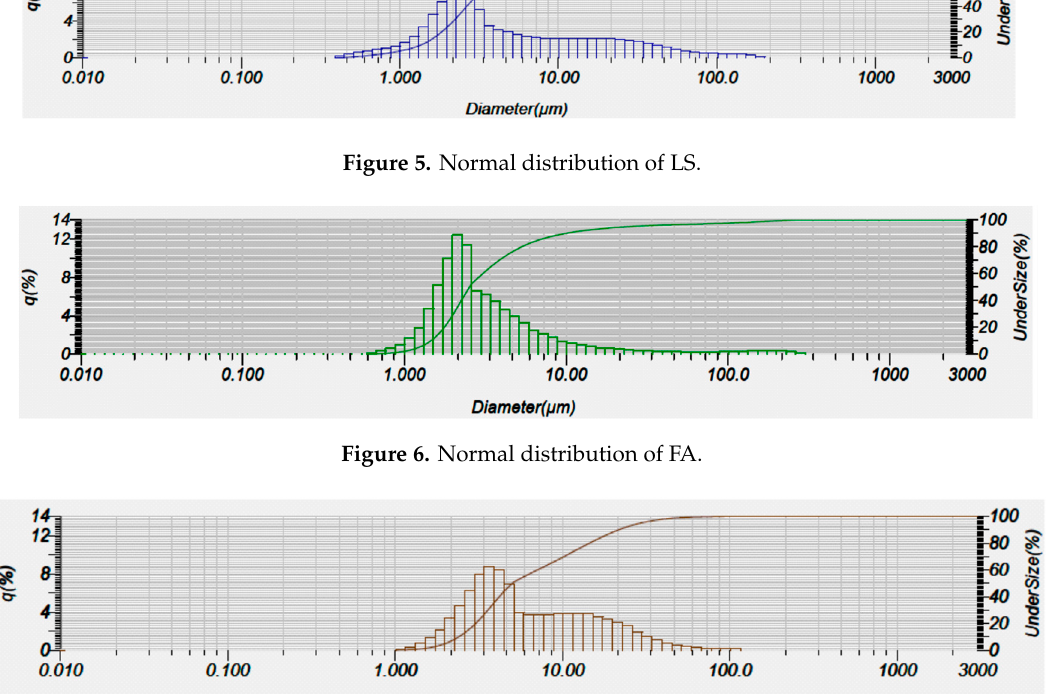
Figure 7. Normal distribution of μ S.